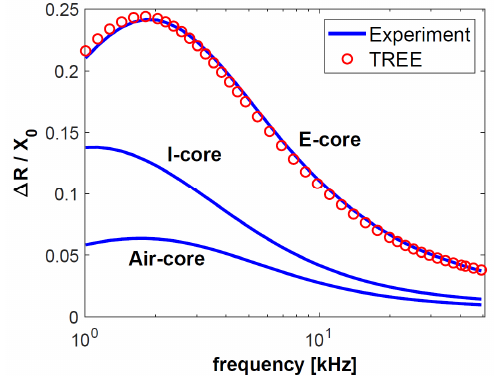
Figure 4. The changes in the resistance Δ R normalised with respect to the reactance X 0 for sample made of aluminium and copper.